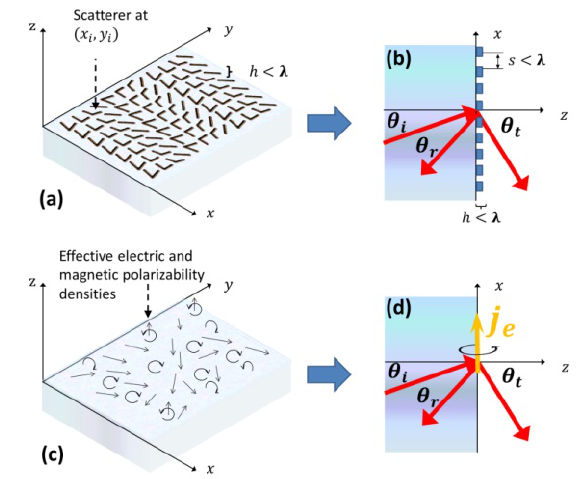
Figure 1: Figure 1 (a) schematic of a metasurface. It consists of an ensemble of subwavelength optical resonators which have been disposed along 2-dimensional planes to scatter light in a controlled manner. Metasurfaces can be designed to control almost any light characteristics including phase, amplitude, polarization and dis- persion. (b) Generalized reflection and refraction of light. (c, d) Substituting the individual scatterers by their effective electric and magnetic surface susceptibilities, the generalized sheet boundary conditions are powerful theoretical tools to predict and model the rapid changes in the electromagnetic fields across a